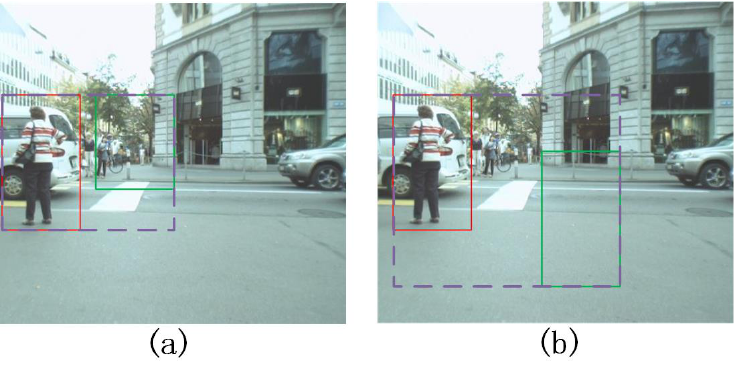
Figure 6. GIOU distance measurement effect display. ( a ) The detection frame is close to the prediction frame. ( b ) The detection frame is far from the prediction frame.